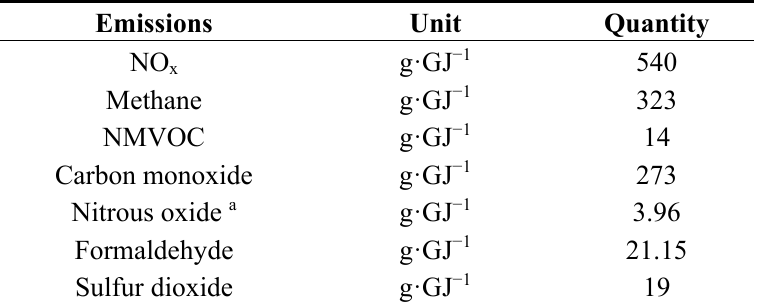
Table 2. Emissions from the CHP engine considered in the biogas plant, per GJ biogas combusted (adapted from [51]).